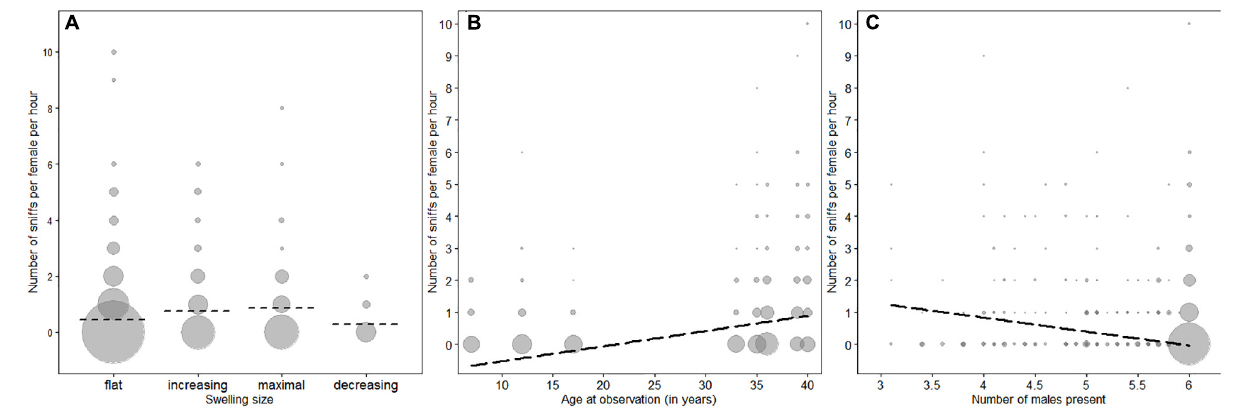
FIGURE 1 | Frequency of sniffs observed per female per session. (A) Influence of the size of the sexual swelling, (B) impact of female age, (C) influence of the number of males present in the group. The size of the circles represents the number of observations; the dashed lines represent the model